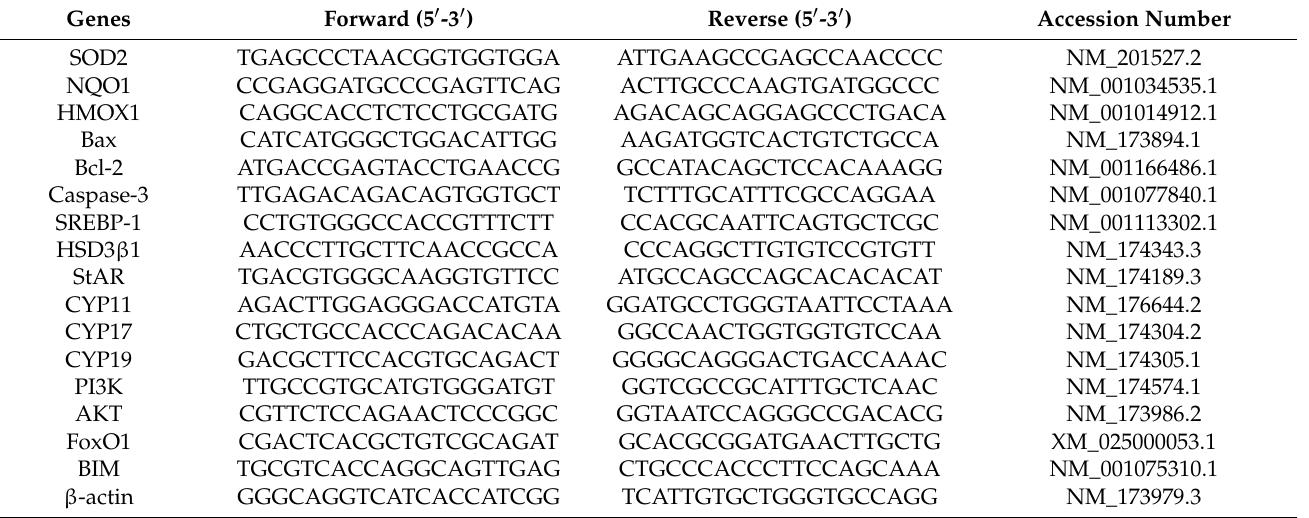
Table 1. Primer sequences of mRNA in this experiment for qRT-PCR